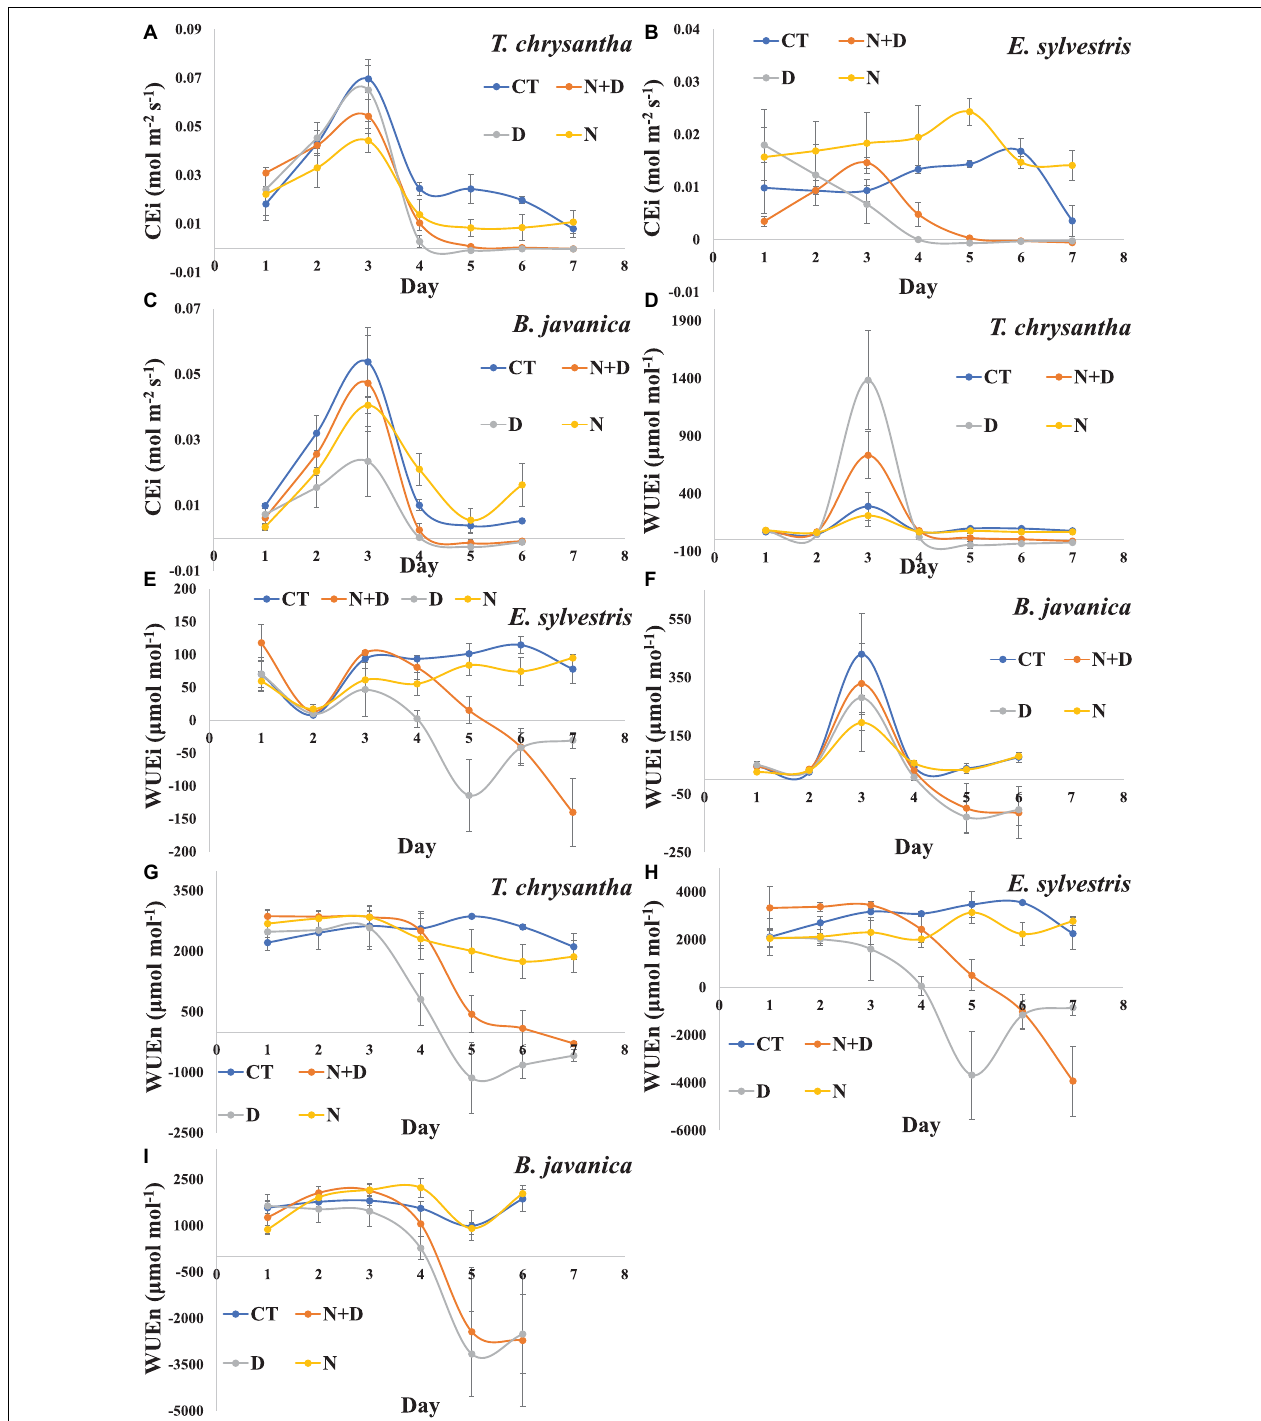
FIGURE 4 | Changes in Instantaneous carboxylation efficiency of CO 2 assimilation (CE i ) (A–C) , intrinsic water-use efficiency (WUE i ) (D–F) , instantaneous water-use efficiency (WUE n ) (G–I) of Tabebuia chrysantha (A,D,G) , Elaeocarpus sylvestris (B,E,H) , and Bischofia javanica (C,F,I) in response to control (CT), nitrogen addition plus drought (N+D), drought (D), and nitrogen addition (N) treatments from day 1 to 7. Error bars were represented